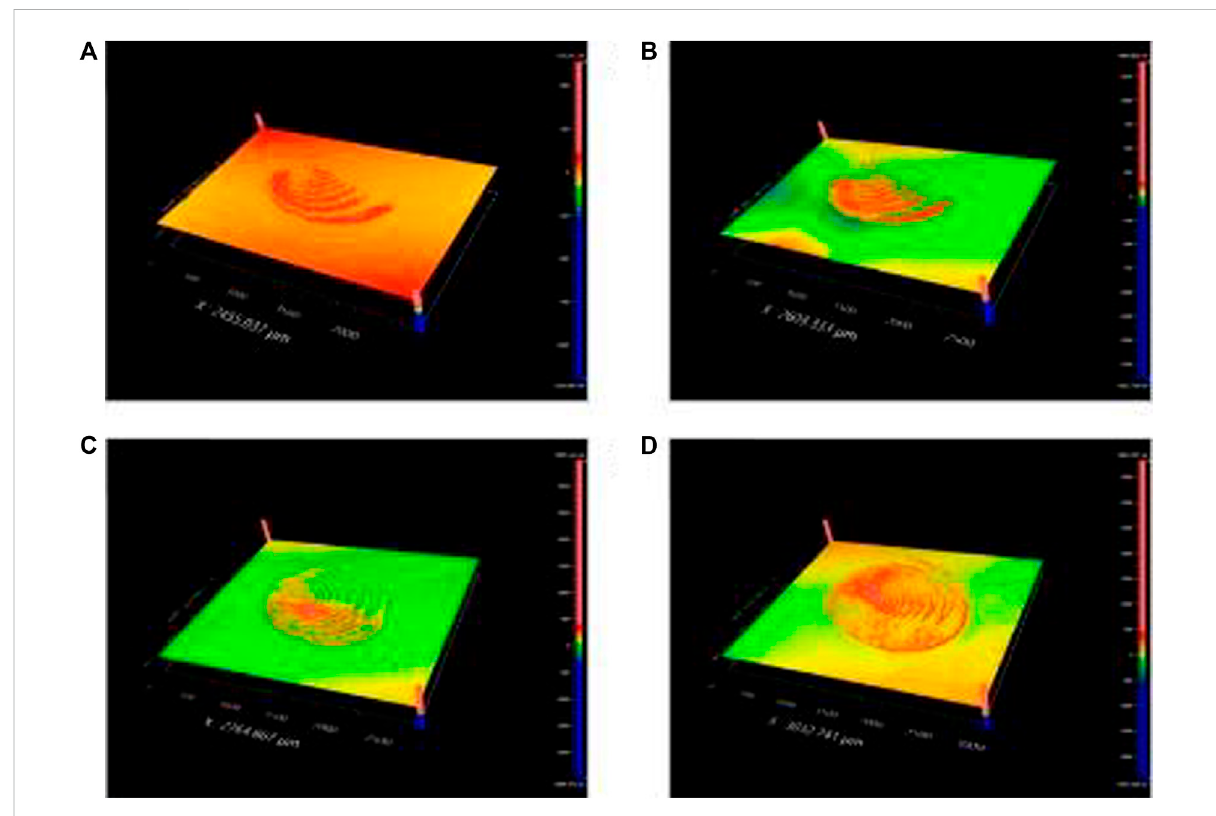
FIGURE 1 Damagepro fi leofanITOthin fi lmsampleirradiatedbyalaseratdifferentenergydensities: (A) 1.03 J/cm 2 , (B) 1.28 J/cm 2 , (C) 1.55 J/cm 2 ,and (D) 2.23 J/cm 2